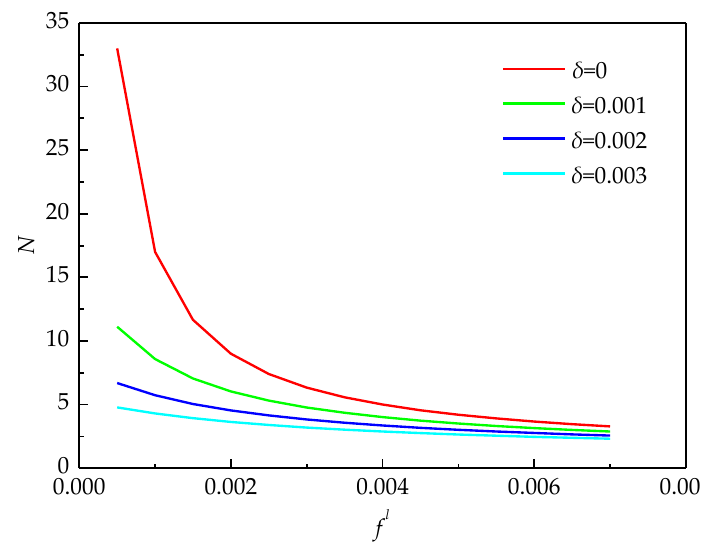
Figure 6 . The relationship between N and f l .